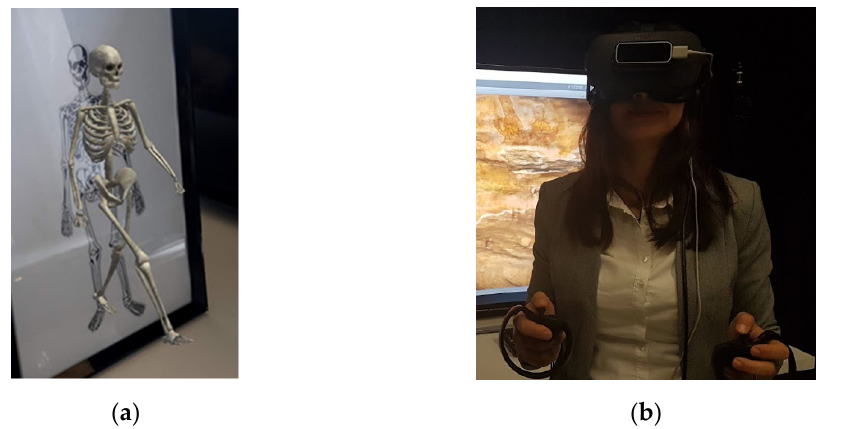
Figure 1. ( a ) Sample of an Augmented Reality project; ( b ) Virtual Reality headset and tools. (Deakin University Cadet